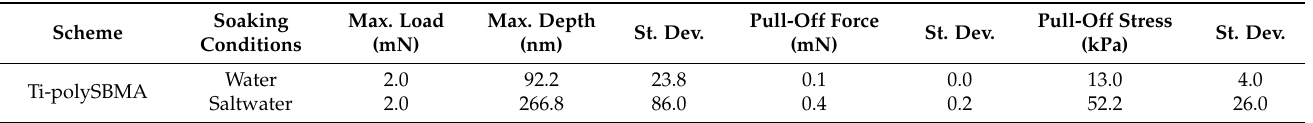
Table 3. Results of the adhesion testing with a cylindrical flat punch on Ti-polySBMA coatings for two soaking conditions. Saltwater designates a 0.6 M NaCl solution.